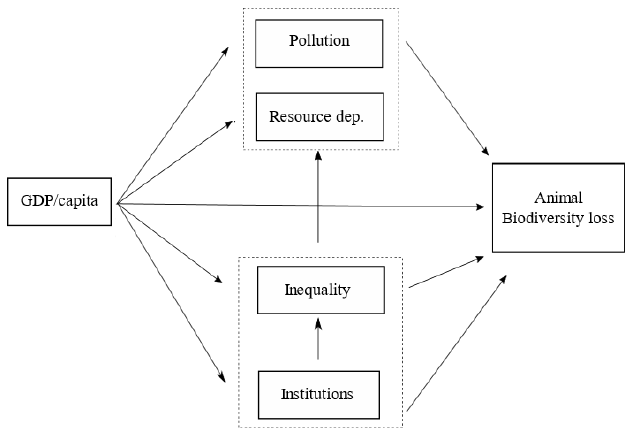
Fig. 1 . Direct and indirect effect pathways from economic growth to biodiversity loss. A conceptual model illustrating the structural relationship.